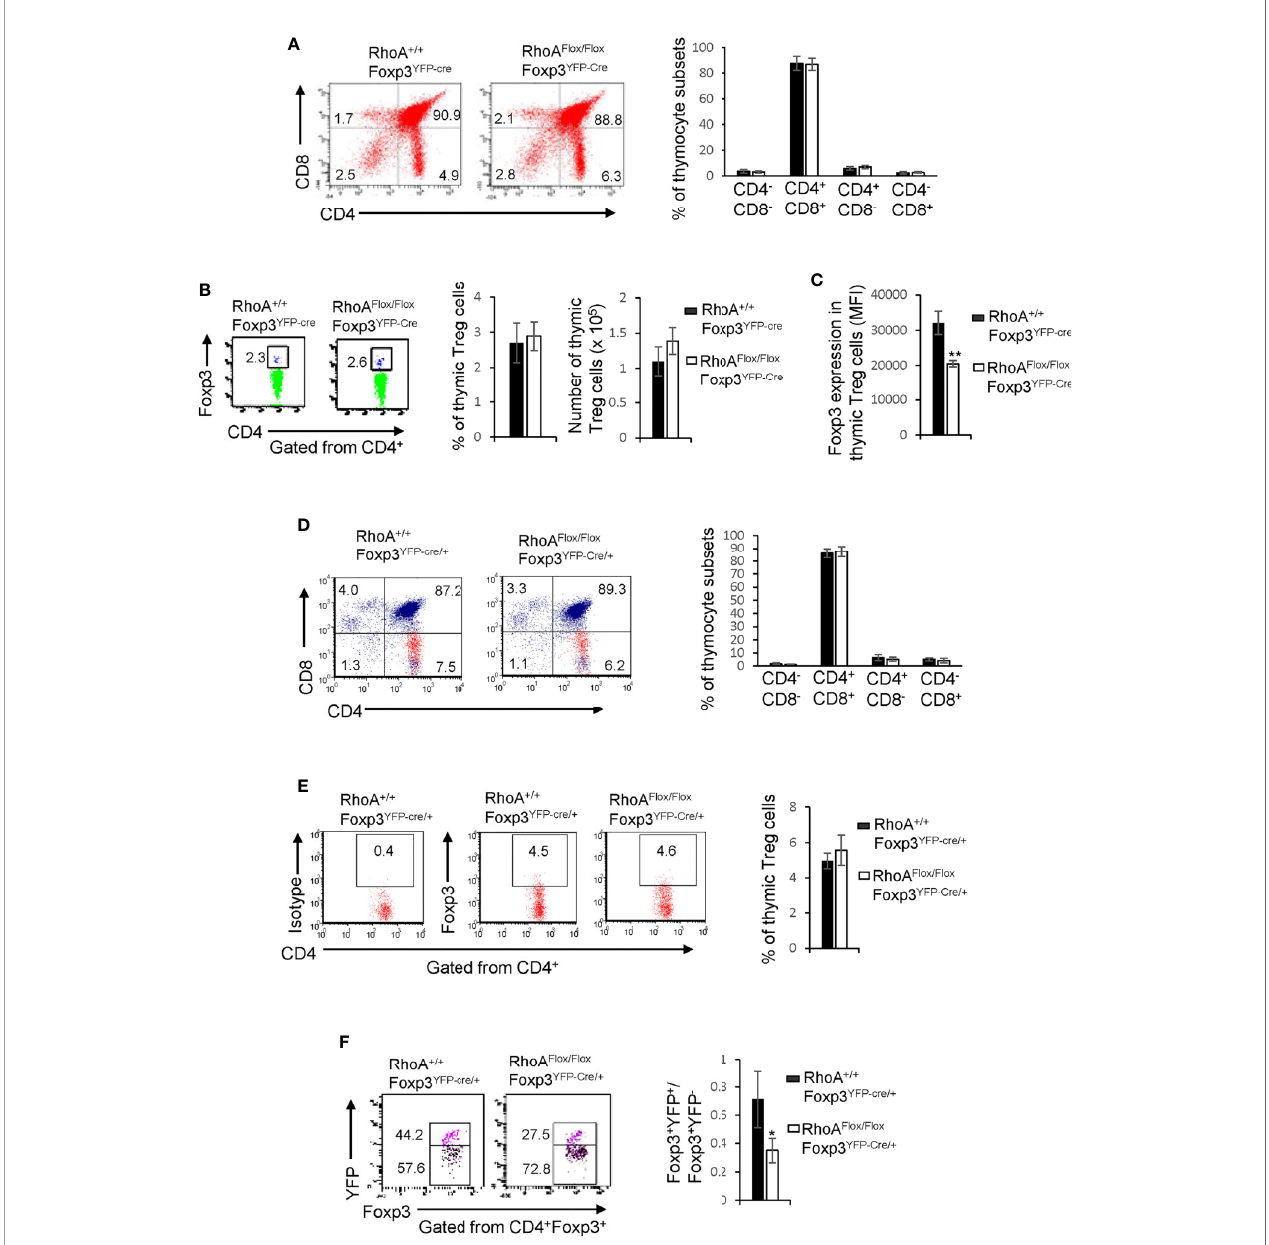
FIGURE 4 | Homozygous RhoA deletion in Treg cells does not affect Treg cell development in the thymus but induces thymic Treg cell plasticity. (A) Left, representative fl ow cytogram of CD4 and CD8 staining in thymocytes from RhoA +/+ Foxp3 YFP-Cre and RhoA Flox/Flox Foxp3 YFP-Cre mice. The numbers indicate percentages of CD4 - CD8 - , CD4 + CD8 + , CD4 + and CD8 + cells in corresponding quadrant. Right, average percentages of CD4 - CD8 - , CD4 + CD8 + , CD4 + and CD8 + cells. (B) Left, representative fl ow cytogram of Foxp3 staining in CD4 + thymocytes from RhoA +/+ Foxp3 YFP-Cre and RhoA Flox/Flox Foxp3 YFP-Cre mice. The numbers indicate percentages of CD4 + Foxp3 + thymic Treg cells. Middle, average percentages of CD4 + Foxp3 + thymic Treg cells. Right, cell numbers of CD4 + Foxp3 + thymic Treg cells. (C) The expression levels (MFI: mean fl uorescence intensity) of Foxp3 in thymic Treg cells from RhoA +/+ Foxp3 YFP-Cre and RhoA Flox/Flox Foxp3 YFP-Cre mice. (D) Left, representative fl ow cytogram of CD4 and CD8 staining in thymocytes from RhoA +/+ Foxp3 YFP-Cre/+ and RhoA Flox/Flox Foxp3 YFP-Cre/+ female mice. The numbers indicate percentages of CD4 - CD8 - , CD4 + CD8 + , CD4 + and CD8 + cells in corresponding quadrant. Right, average percentages of CD4 - CD8 - , CD4 + CD8 + , CD4 + and CD8 + cells. (E) Left, representative fl ow cytogram of Foxp3 staining in CD4 + thymocytes from RhoA +/+ Foxp3 YFP-Cre/+ and RhoA Flox/Flox Foxp3 YFP-Cre/+ female mice. The numbers indicate percentages of CD4 + Foxp3 + thymic Treg cells. Right, average of percentages of CD4 + Foxp3 + thymic Treg cells. (F) Left, representative fl ow cytogram of Foxp3 + YFP + and Foxp3 + YFP - cells in CD4 + Foxp3 + thymic Treg cells from RhoA +/+ Foxp3 YFP-Cre/+ and RhoA Flox/Flox Foxp3 YFP-Cre/+ female mice. The numbers indicate percentages of Foxp3 + YFP + and Foxp3 + YFP - cells. Right, the ratio of Foxp3 + YFP + versus Foxp3 + YFP - cells. n = 3 mice. Data are representative of two independent experiments. Error bars indicate SD. *p < 0.05, **p <